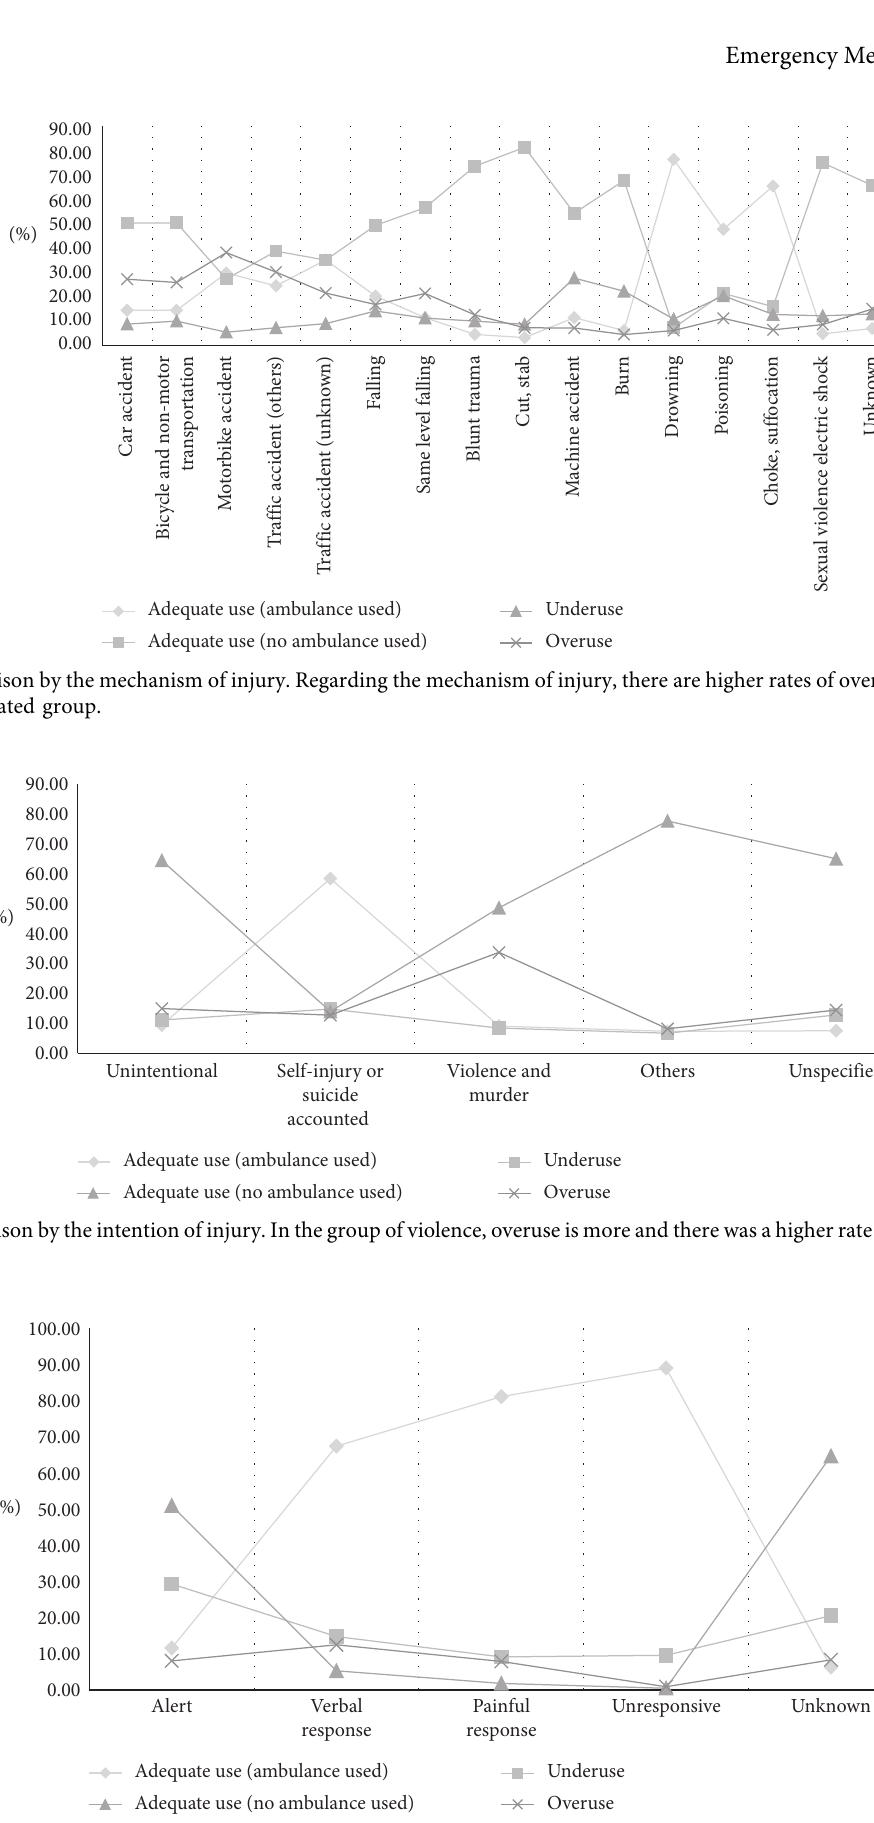
Figure 4: Comparison by initial mental status. By initial mental status, the pattern of ambulance use is different. In the alert group, there was a higher rate of underuse.